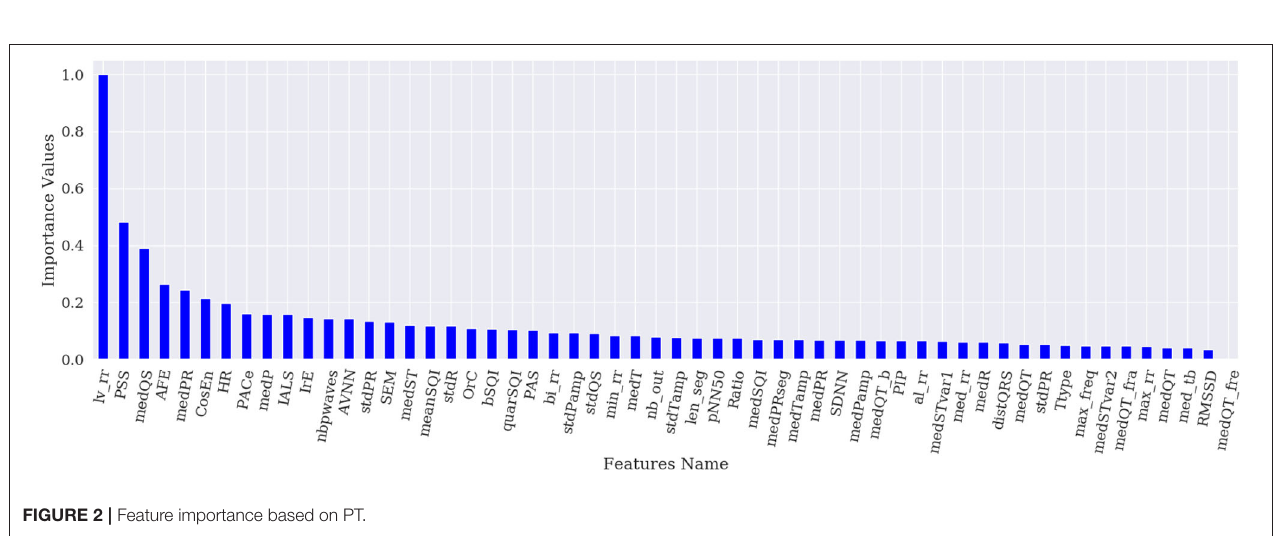
FIGURE 2 | Feature importance based on PT.